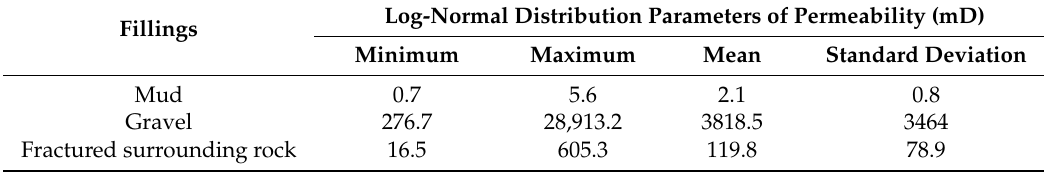
Figure 5. Comparison between the permeability input information and the measured permeability data. Table 4. Permeability results of the fillings in ISWZs.